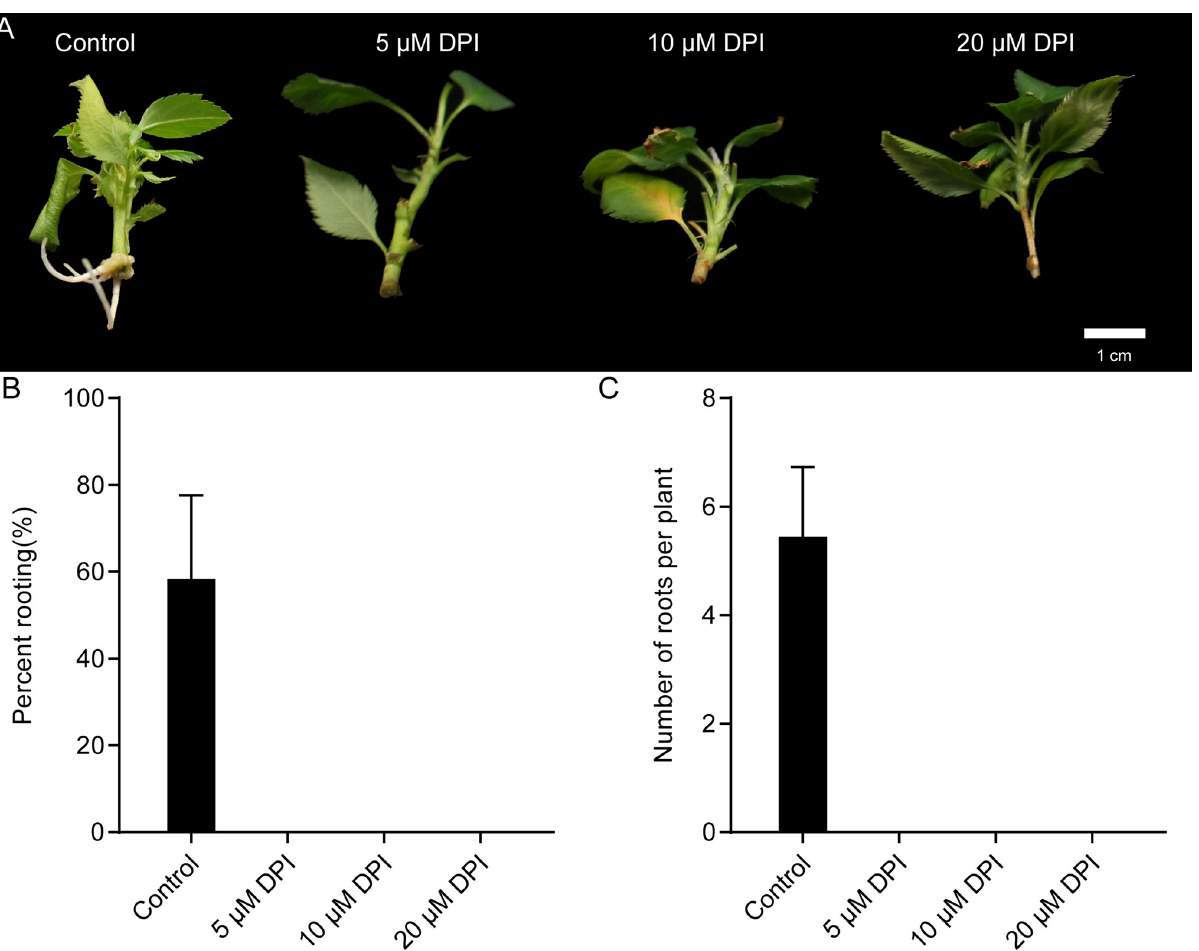
Fig 4. Effects of DPI on adventitious root formation of apple stem cuttings. (A) Adventitious root formation in apple stem cuttings after 18 days in rooting medium (control) or rooting medium supplemented with DPI (5 μ M, 10 μ M, and 20 μ M). Percent rooting (B) and adventitious root number per cutting (C) were counted at 18 days. Bars indicate mean and Standard Deviation (SD) of three biological replicates; n = 6 individuals per